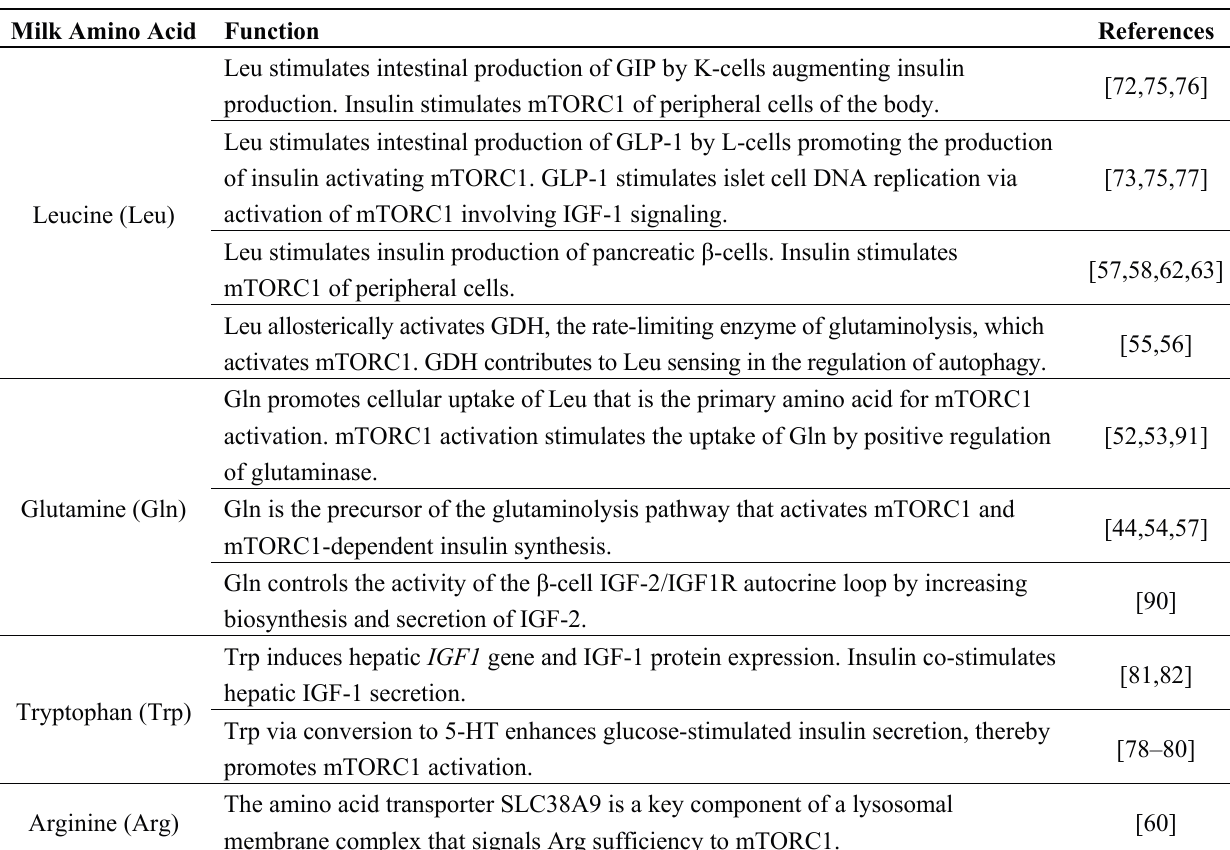
Table 2. Milk-derived amino acid signals that activate mTORC1-dependent translation. Milk Amino Acid